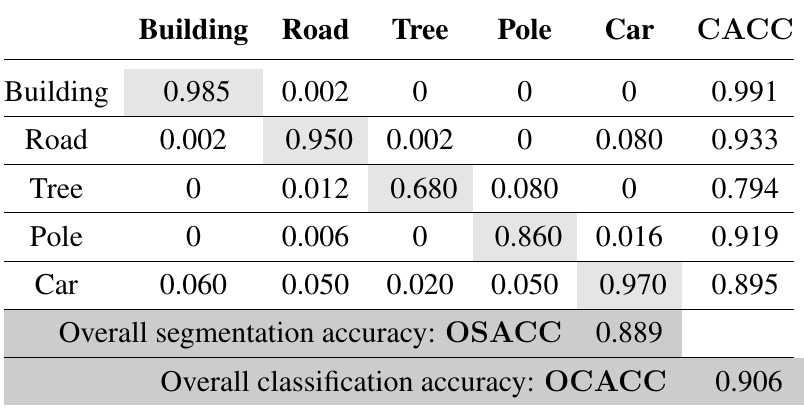
Table 6. Classification results of scene-B with the new evaluation metrics.